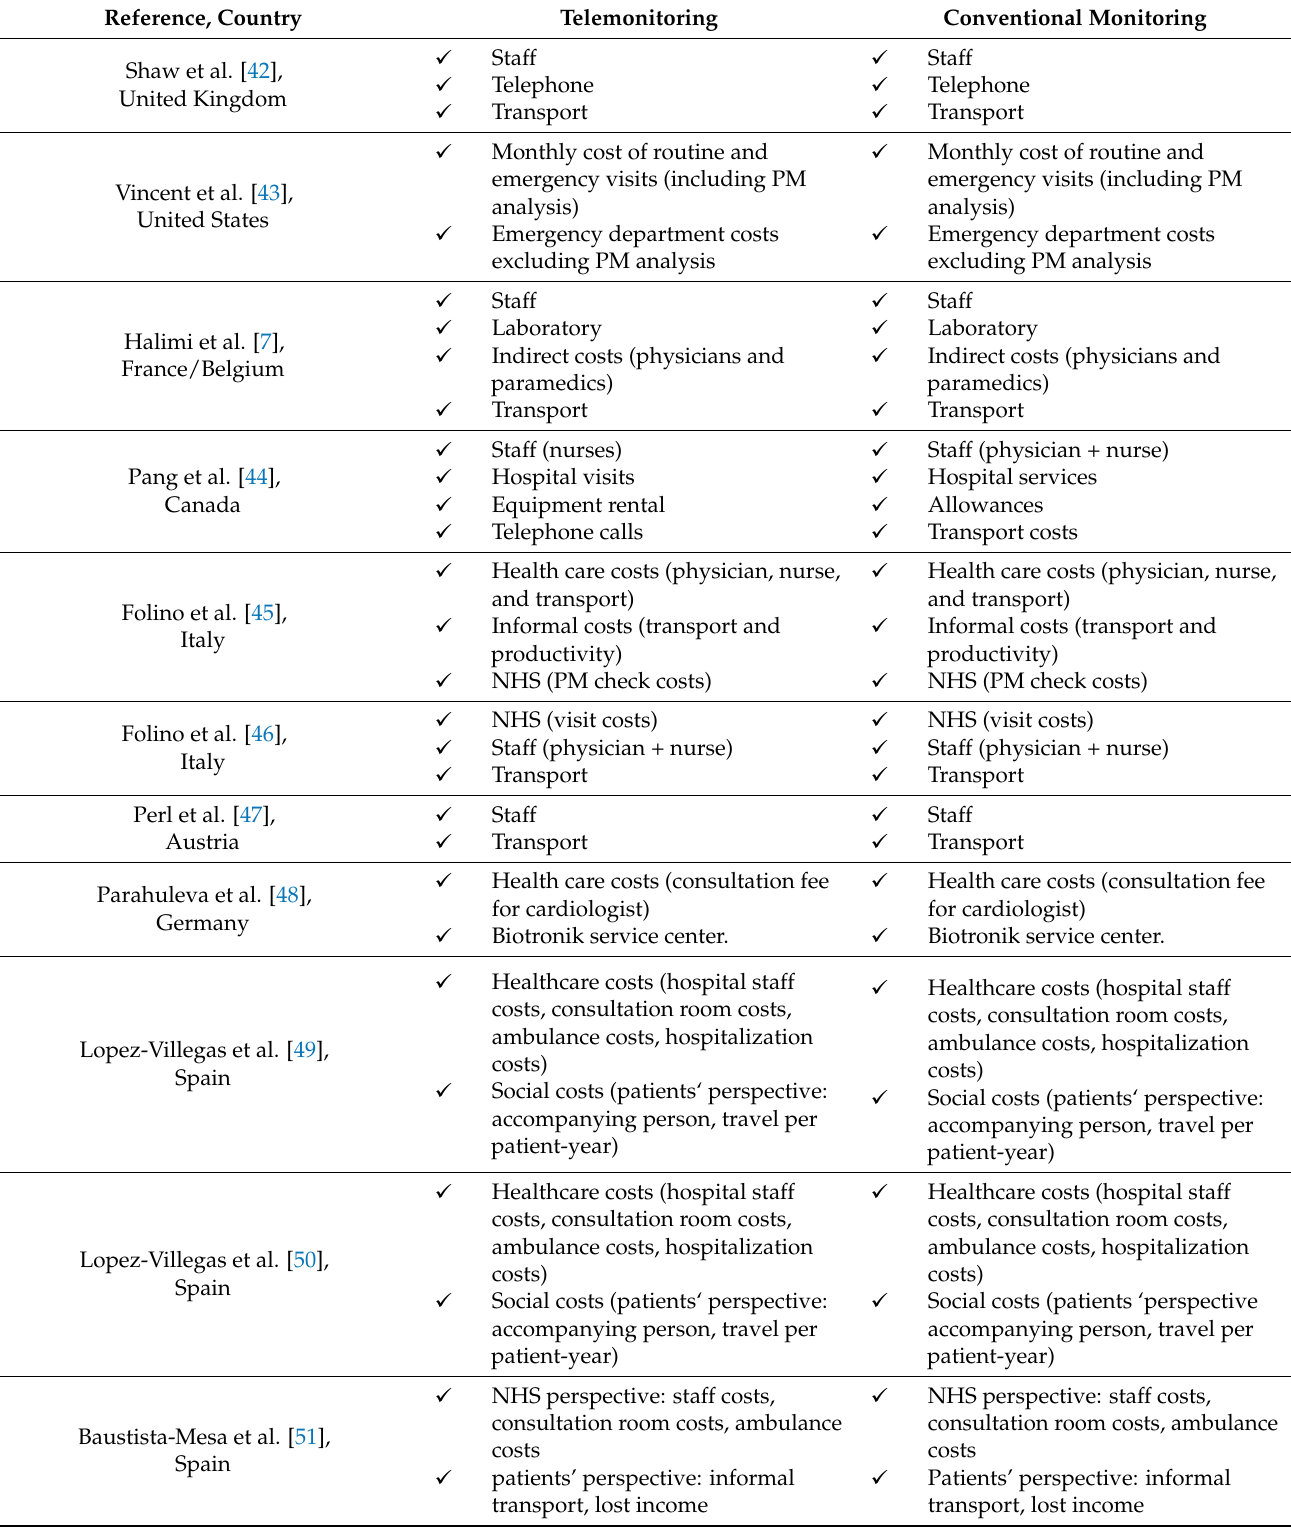
Table 3. Costs evaluated in both modalities of follow-up.